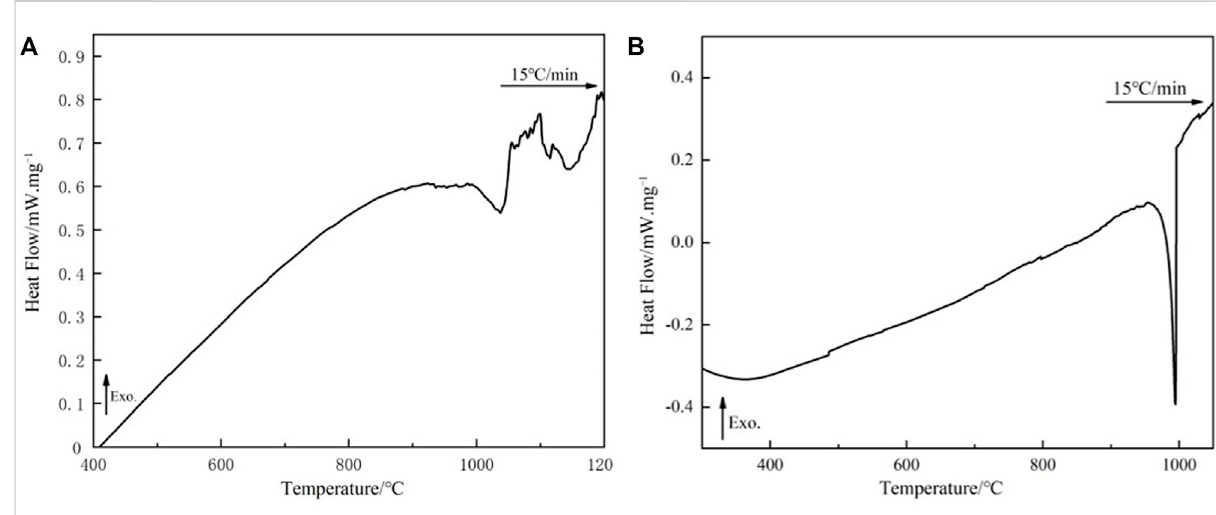
FIGURE 1 DSC curves of brazing alloys: (A) melting circuit board and (B) melting pure metals.